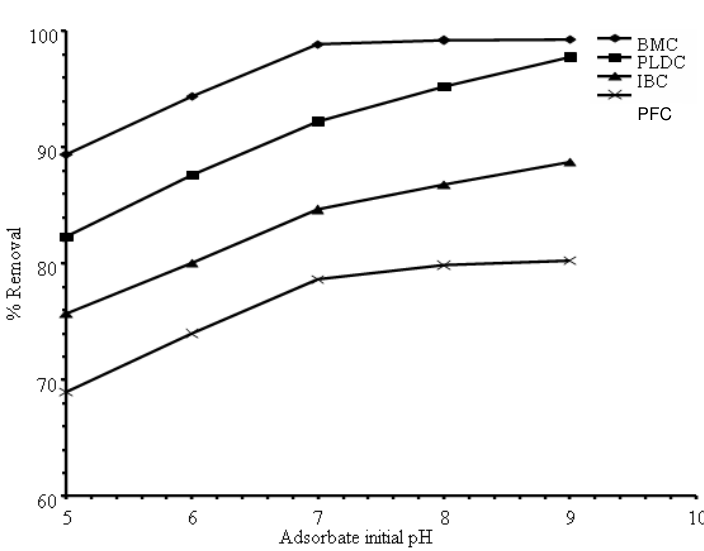
Figure 6 . Effect of adsorbate initial pH on the percentage removal of